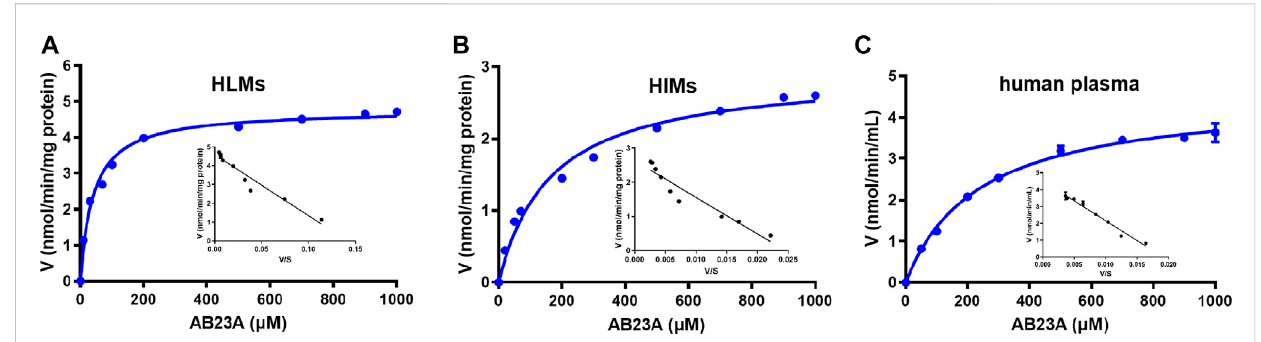
Michaelis − MentenkineticplotsofAB23AhydrolysisinHLMs (A) ,HIMs (B) ,andhumanplasma(25%dilution) (C) .Theexperiments wereconducted in triplicate, while the data were expressed as mean ±